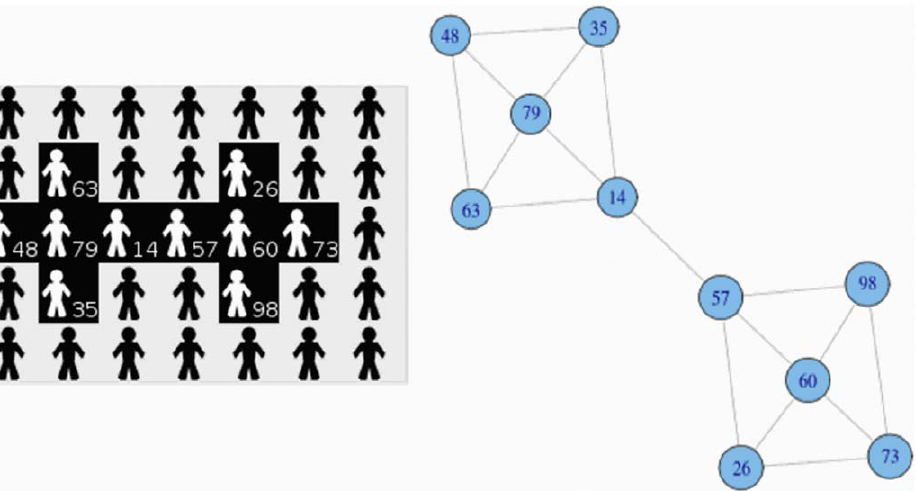
Figure 7. Idealized case of white-tagged players and the underlying intratype interaction network. We have analysed the effects that appear in the stylized configuration showed on the left of the figure. On the right, we represent the underlying interaction structure for the intratype